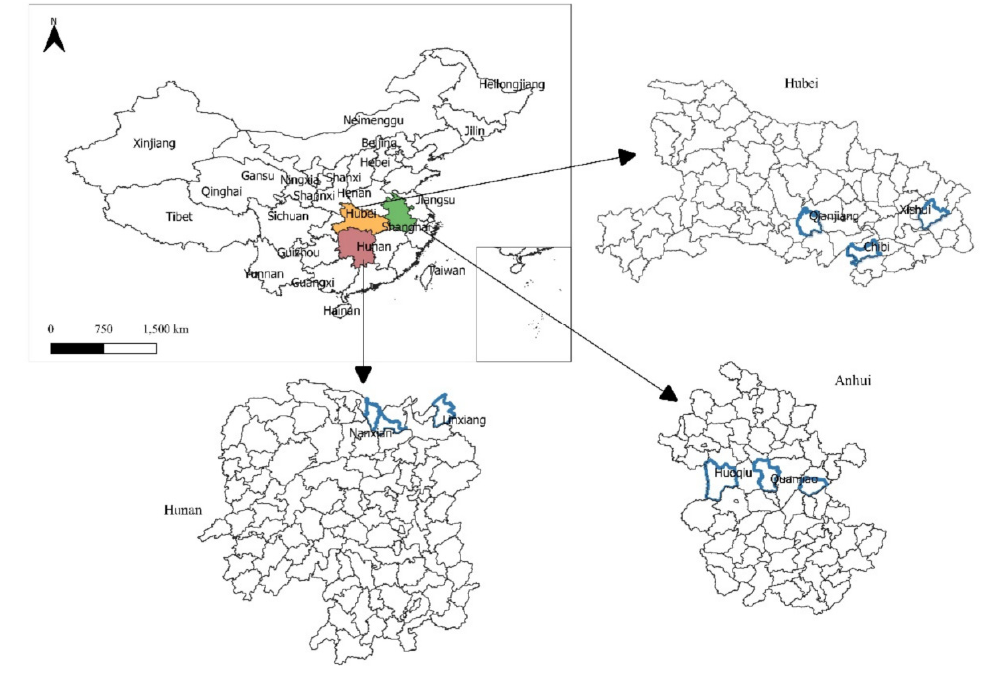
Figure 1. Location of the study area.